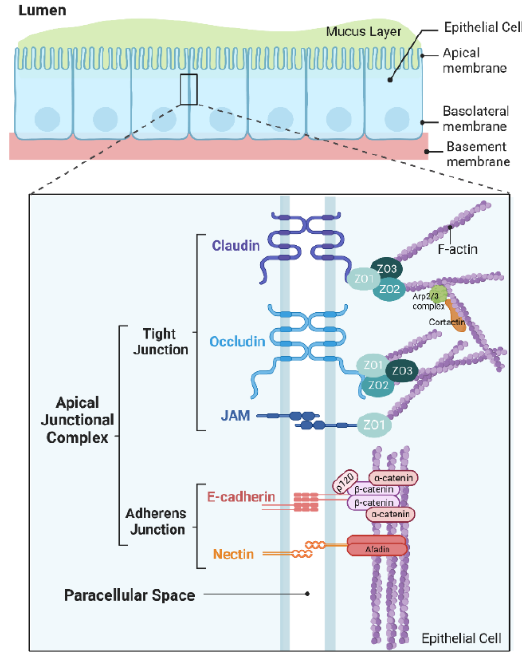
Figure 1. Schematic diagram illustrating the structure of apical junction complexes in the airway epithelium. In the human airway epithelium, the surface mucus layers and the physical barrier formed by airway epithelial cells serve as the first line of defense against the external environment. The apical junctional complexes (AJCs) between adjacent epithelial cells establish cell polarity and restrict epithelial permeability via maintaining cell – cell contact. AJCs are located on the top lateral membranes between neighboring cells and include tight junctions (TJs) and adherens junctions (AJs). The inset shows an enlarged illustration of several protein components of TJ and AJ. Claudin, occludin, and junctional adhesion molecule (JAM) are examples of TJ transmembrane proteins. E-cadherin and nectin are shown as examples of the AJ transmembrane proteins. These proteins interact with cytoplasmic adapter proteins, such as zonula occludens (ZO-1/2/3) and β -catenin, to connect to the prejunctional actin cytoskeleton. The assembly and remodeling of the filamentous actin (F-actin) network are critical for the epithelial barrier function and are regulated by key organizers such as cortactin and actin-related protein-2/3 (Arp2/3) complex. This image was created with